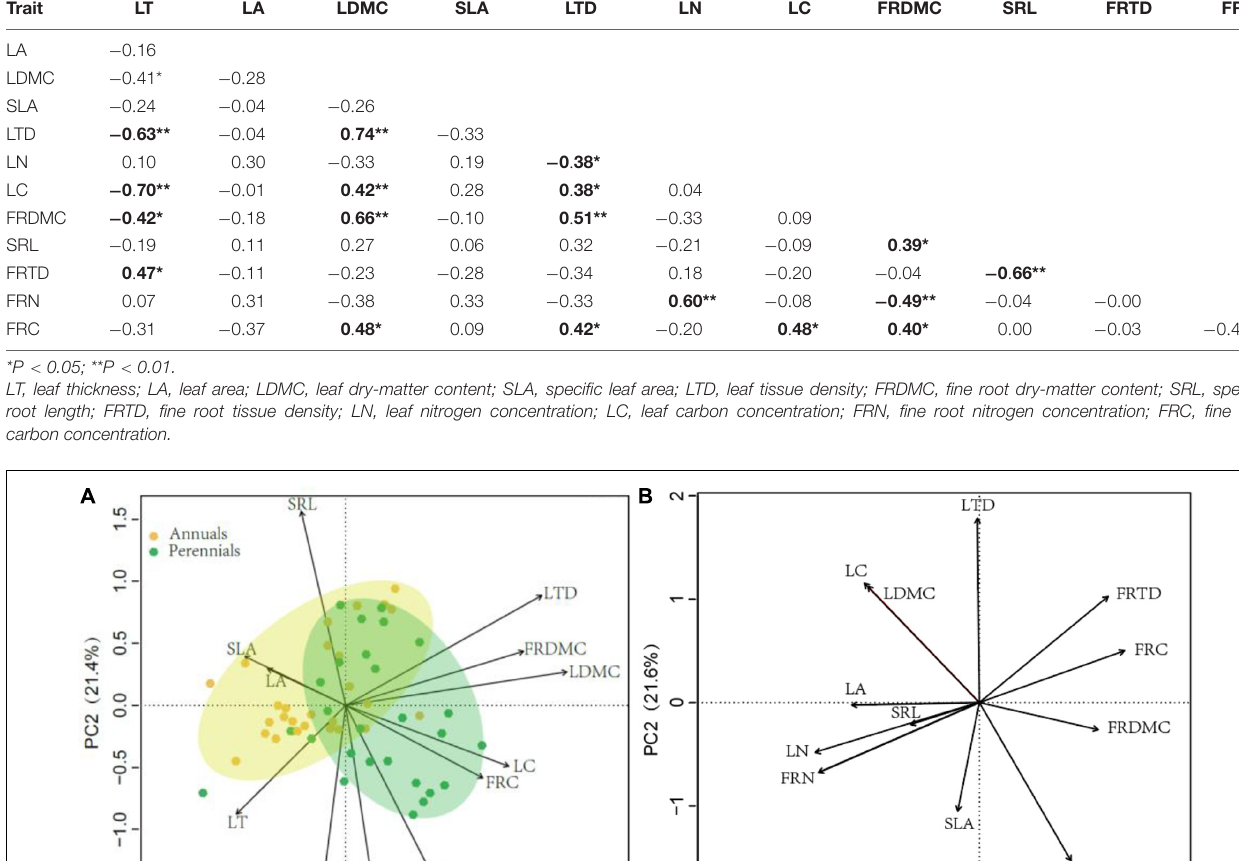
TABLE 4 | Matrix of Pearson’s correlation coefficients for the relationships between leaf and fine root traits in annuals ( n = 22). Trait LT